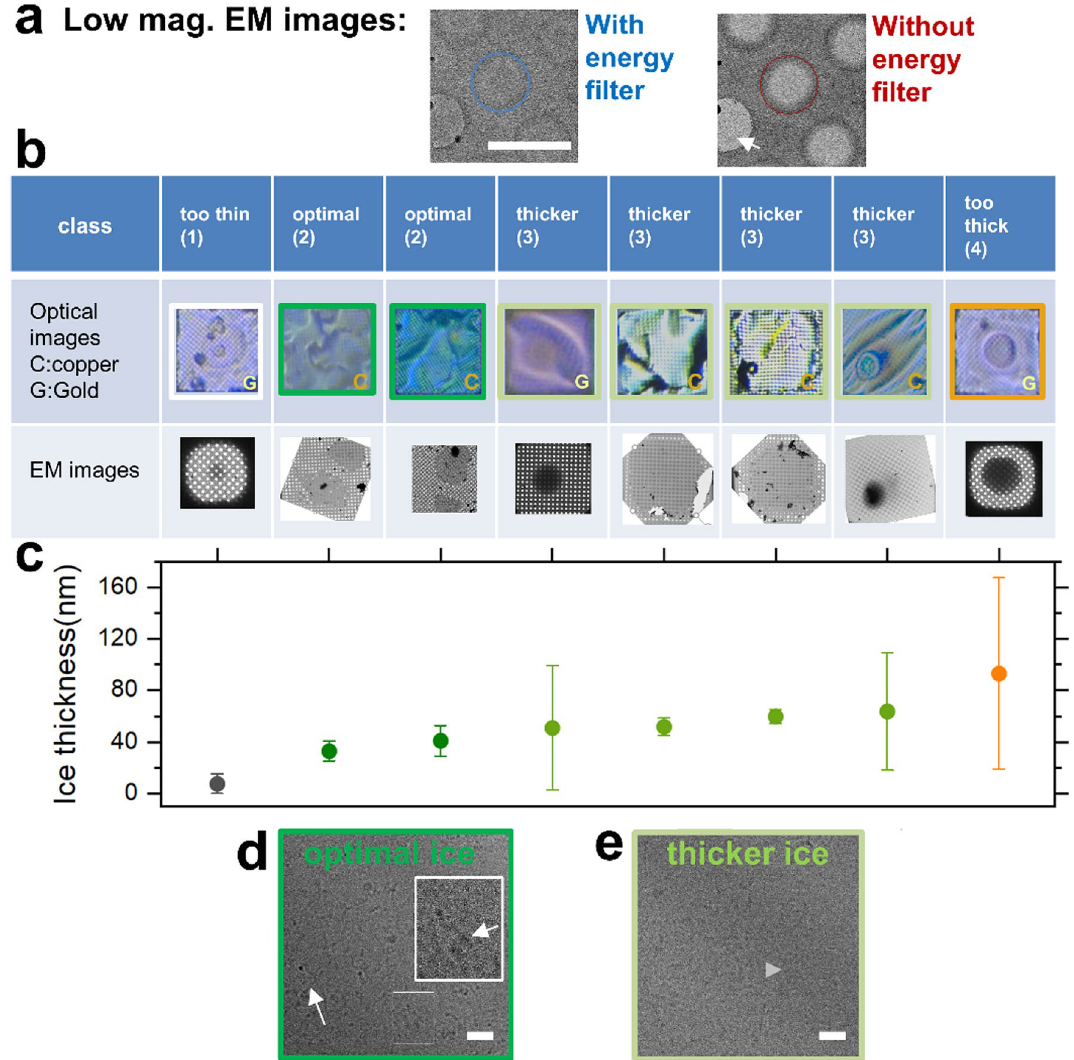
Figure 3. Validation using EM for the ice thickness determination. ( a ) Absolute ice thickness measurement using EM. Low magnification EM images showing holes in a grid square, and acquired with (left image) and without (right image) the activation of an energy filter. The local absolute ice thickness can be determined from the different intensities in given holes (blue and red circles) (Methods). ( b ) Correlation between the ANNICAS grid square classification and the ice layers measurements obtained by EM. Higher row ‘Optical images’: optical interferometric images for eight representative grid squares classified by ANNICAS. Middle row ‘EM images’: corresponding low-magnification EM images (if necessary after image rotation). ( b ) Representative ice thicknesses for these grid square (samples in the same order than in ( c )) obtained by calculation of the average ice thickness (Methods) in 10 holes randomly distributed. The standard deviations of the thickness values for the 10 positions are indicated as bars. The standard deviations are large for many samples, reflecting the strong inhomogeneity of their respective ice layers. The ice thicknesses are consistent with our classification, confirming that our ANN-based analysis reliably detects and classifies the grid squares according to the ice thickness/quality. ( d–e ) High-resolution cryo-EM images in a class 2 ( d ), and in a class 4 ( e ) grid squares. SbcCD particles are distinctly visible in the left insert (white arrows), whereas the particles in too thick ice on the right are much more crowded, partially forming aggregates (grey arrow), and appear in addition with a lower contrast. Scale bars 20 Fig. 3e) grid square. In the sample image for class 2, the lengthy SbcCD particles are clearly visible individually (white arrows in the insert), and exhibit a density appropriate for imaging. In contrast, the particles visible in the class 3 image are more crowded, forming local aggregates (grey arrow) and exhibit a lower contrast, confirming our classification once again. Finally, in class 4 the contrast is completely lost in EM images (as can be seen from the dark pattern in the center of the rightmost grid square EM image in Fig. 3b), whereas in class 1 the vitreous ice layer is too thin to fit the particles. Additional high-resolution cryo-EM are shown in Supplementary Fig. 5 for classes 1–4. Finally, as an additional control for our classification, we checked if class 1 can also be detected in